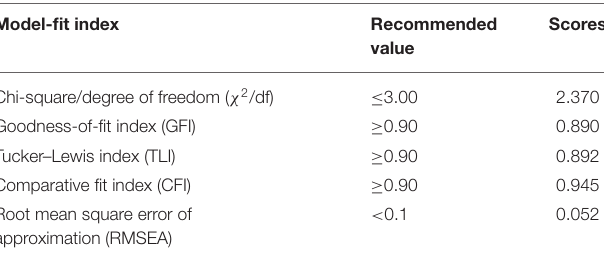
TABLE 2 | Goodness-of-fit